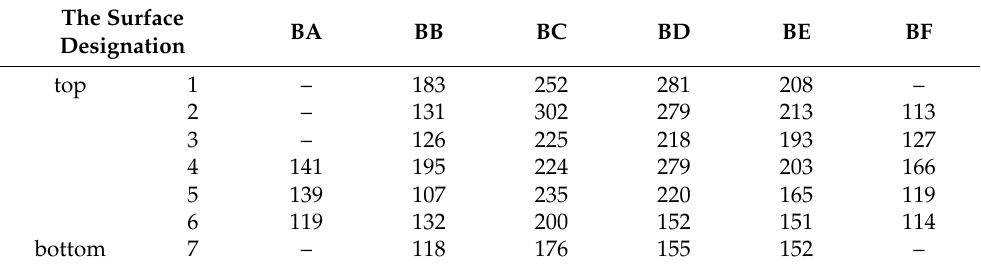
Table 4. The results of hardness measurements on back surface in HLD.